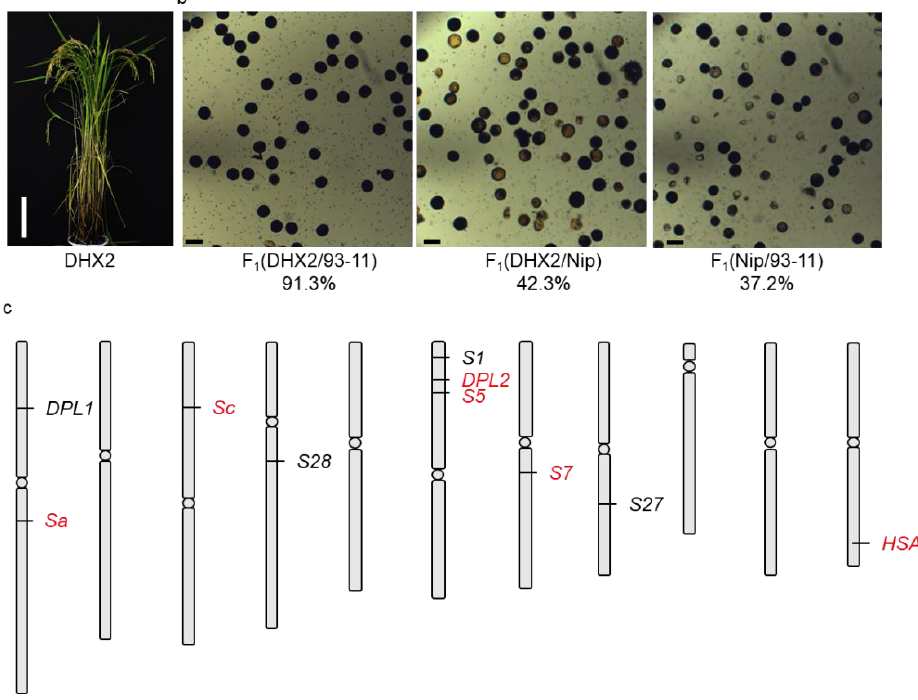
Figure 1. DHX2 exhibited hybrid sterility when crossing with other GJ varieties ( a ) The plant architecture of GJ variety DHX2. Scale bar: 20 cm; ( b ) The pollen phenotypes of F 1 plants derived from the cross of DHX2/93-11, DHX2/Nip, and Nip/93-11. Scale bar: 50 μm; ( c ) The loci for hybrid sterility. The loci that have been cloned from XI / GJ cross were highlighted in red color.